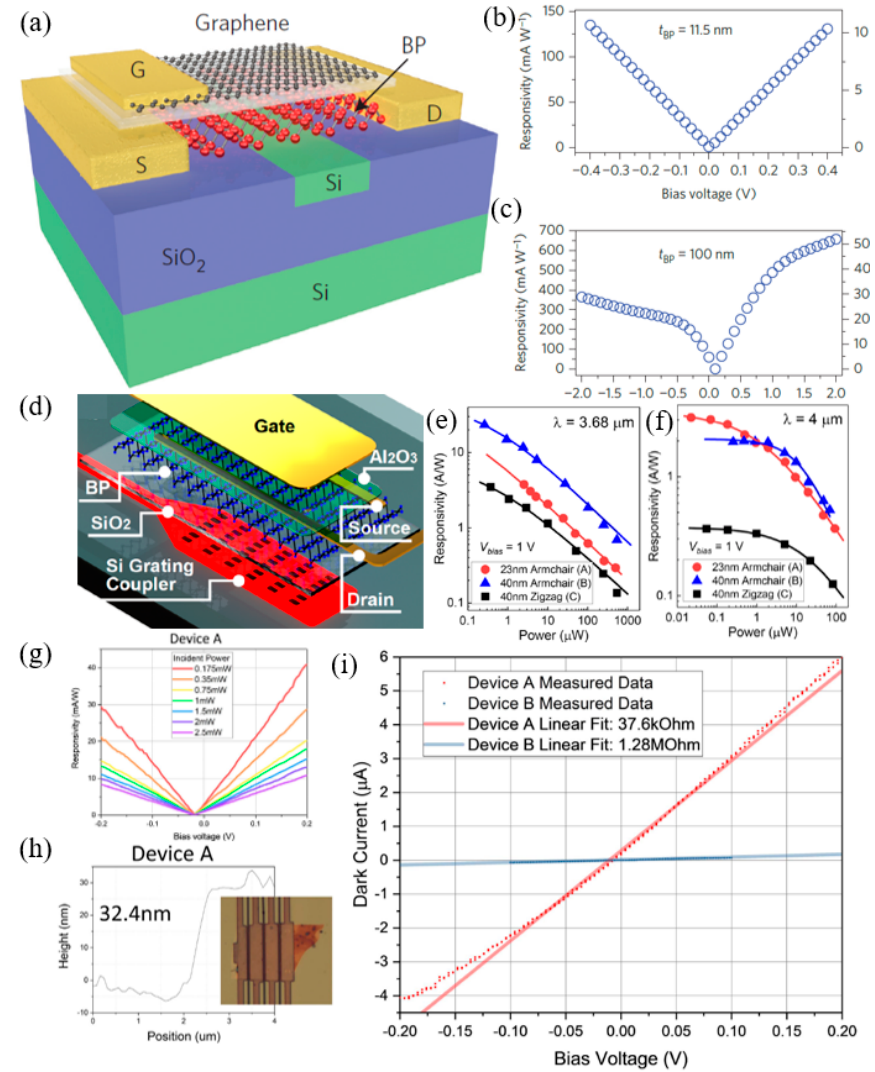
Figure 20. ( a ) 3D demonstration of a BP electric detector with a graphene tip grid. Comparison of the inherent responsivity and internal quantum efficiency (QE) of ( b ) 11.5 nm and ( c ) 100 nm thick BP with application bias. tBP is the thickness of BP [302]. ( d ) An enlarged view of the device output of the system on the waveguide integrated chip with a BP PD. ( e ) The power of both devices depends on the response rate at ( e ) 3.68 μ m and ( f ) 4 μ m [303]. Copyright 2018 American Chemical Society. ( g ) AFM and microscope images from Device A. ( h ) Measured (dots) and linear fit (lines) dark current and resistance of Devices A. ( i ) The relation between the response rate of Device B and the incident laser power [304]. Copyright 2018 IOP Publishing Ltd.